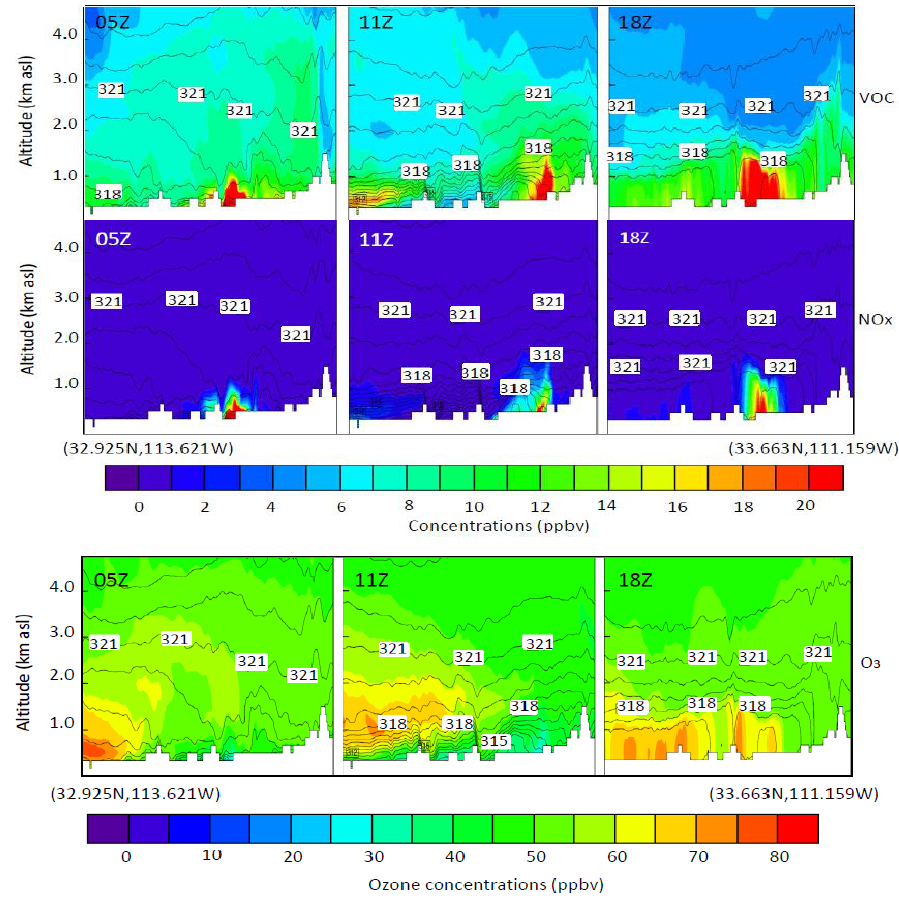
Figure 14. The vertical distribution of VOC (top), NO x (middle), and O 3 (bottom) along the cross-section D’D (shown in Fig. 1b) in the Gila River Basin, Arizona at 05:00, 11:00, and 18:00UTC, 18 July 2005. Contours are potential temperature with 1K